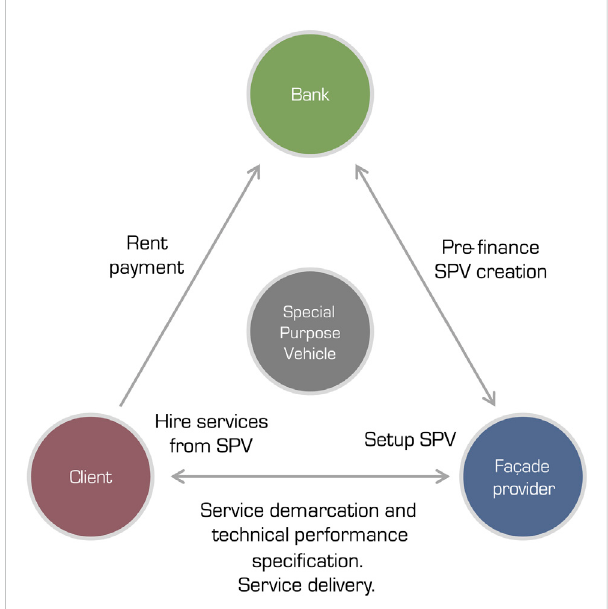
FIGURE 5 Structure for the fi nancing and contractual management of a